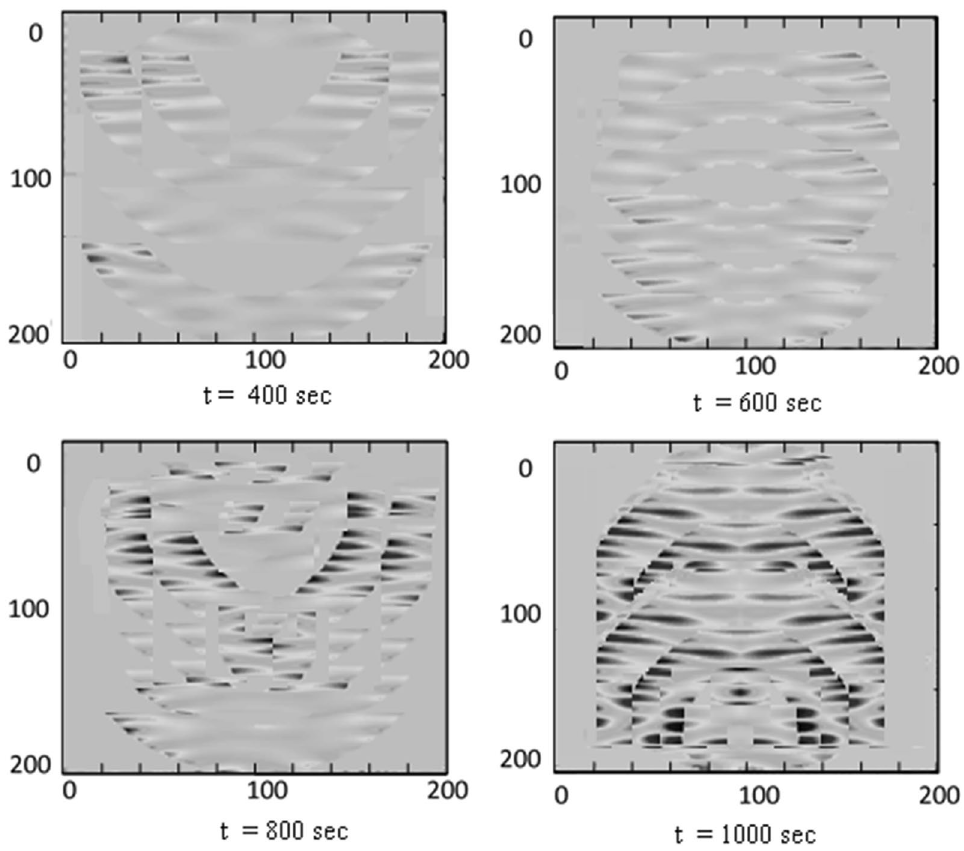
Figure 12. Snapshots at various time of the amplitude of the stress in the tip of the needle.